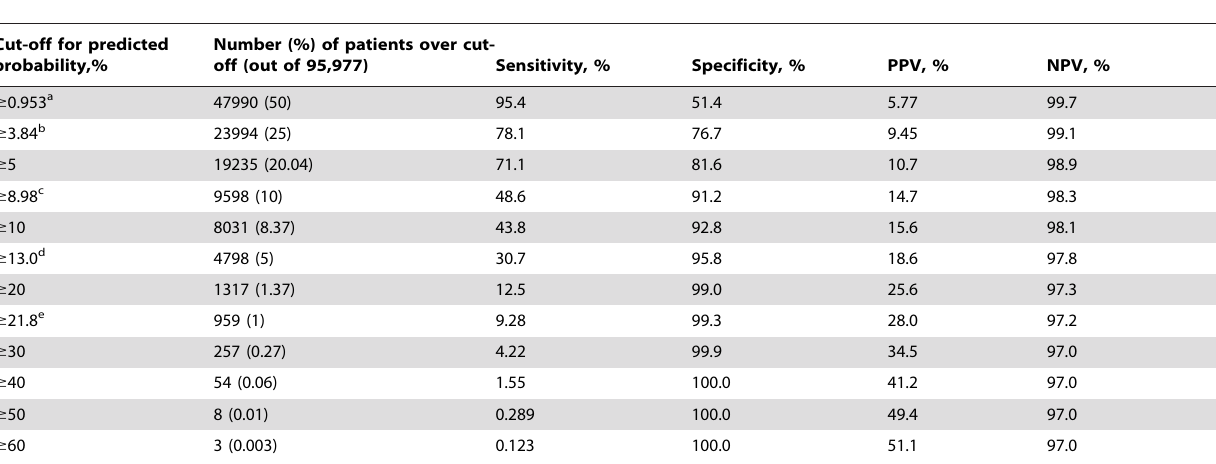
Table 5. Performance measures for different cut-offs of predicted probability of mortality for the final model excluding all LFT